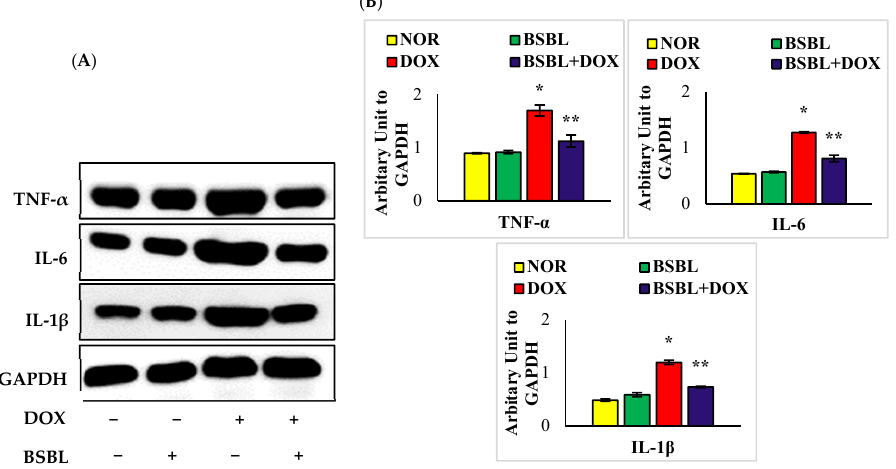
Figure 3. Effect of α -Bisabolol on the expressions of proinflammatory cytokines (TNF- α , IL-6, and IL-1 β ) in the kidney of normal and DOX-injected rats. ( A ). Representative images of West- ern immunoblot analysis for TNF- α , IL-6, and IL-1 β . ( B ) Densitometric analysis of renal protein expressions of TNF- α , IL-6, and IL-1 β assessed by Western blot analysis revealed that DOX-injected rats showed a considerable ( p < 0.05) increase in the renal protein expressions of proinflammatory cytokines compared to normal control rats while α -Bisabolol treatment showed significant ( p < 0.05) decrease in the expressions of cytokines in the kidney compared to DOX-alone treated rats. Im- munoblotting analysis was done in duplicates; columns not sharing a common symbol (*, **) differ significantly with each other (* p < 0.05 vs. normal control, ** p < 0.05 vs. DOX